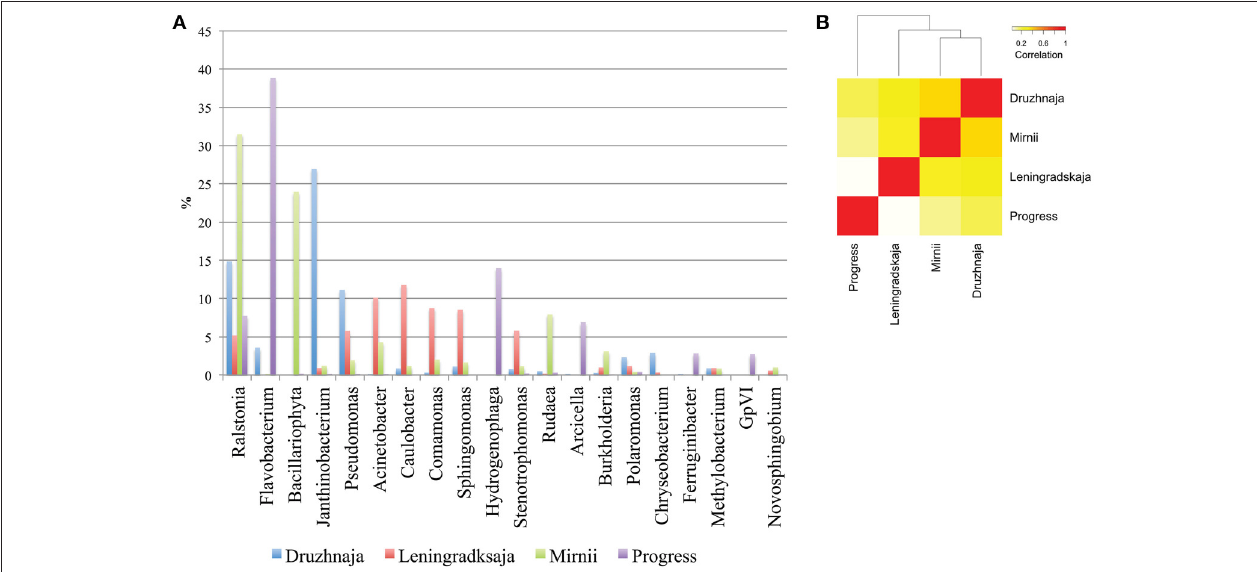
FIGURE 3 | Genus-level bacterial diversity in Antarctic snow samples based on PCR amplicon library. (A) Frequencies of reads corresponding to 20 most abundant genera present in all four samples are shown. For each genus, the height of color-coded bars reflects the percentage of corresponding reads in the entire sample from each station. (B) A heatmap comparing genus-level bacterial diversity and abundance for 255 genera detected in Antarctic snow samples. The colors show the extent of relatedness between the samples from each station as indicated in the legend.